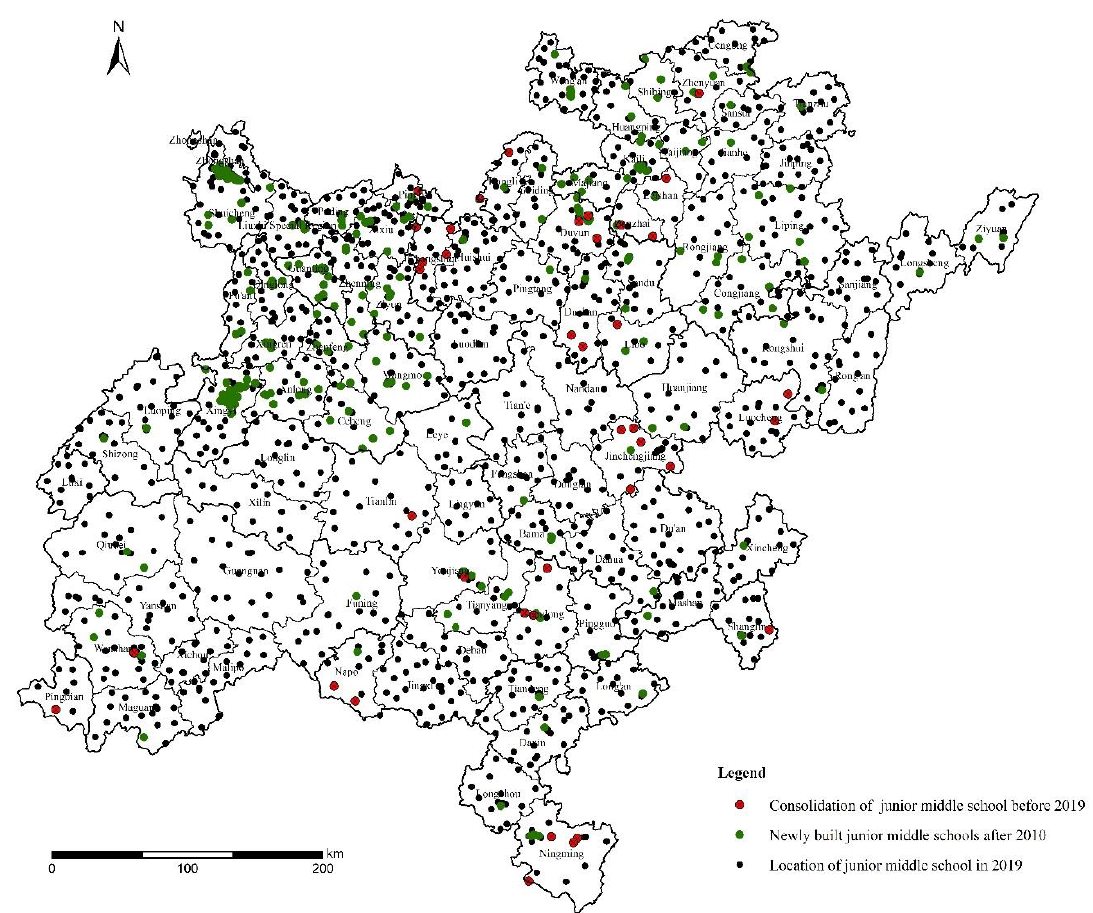
Figure 1. Spatial distribution of junior high school in the YGGRD.